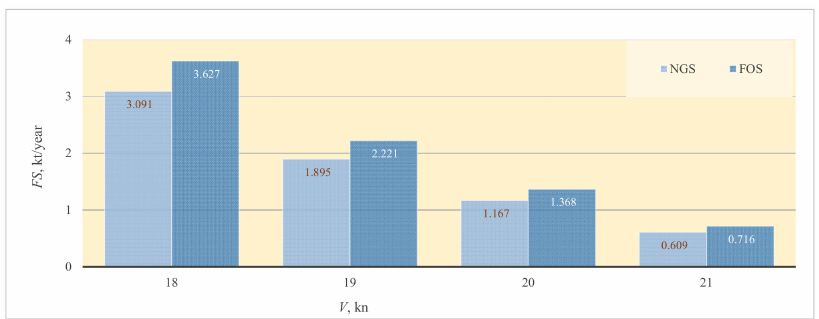
Figure 25. The fuel savings per year for navigation under RWC.